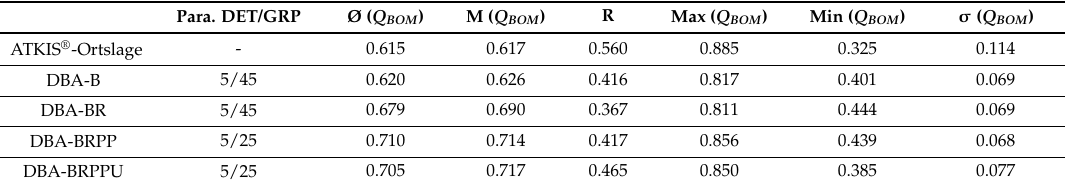
Table 3. Results of the single feature evaluation (Best parameter set DET/GRP; arithmetic mean Ø, median m, range as difference of Max and Min value and standard deviation σ of Q BOM ).